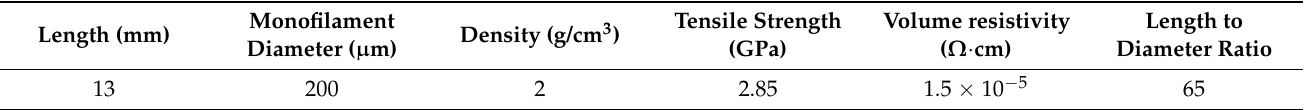
Table 3. Performance parameters of steel fiber.